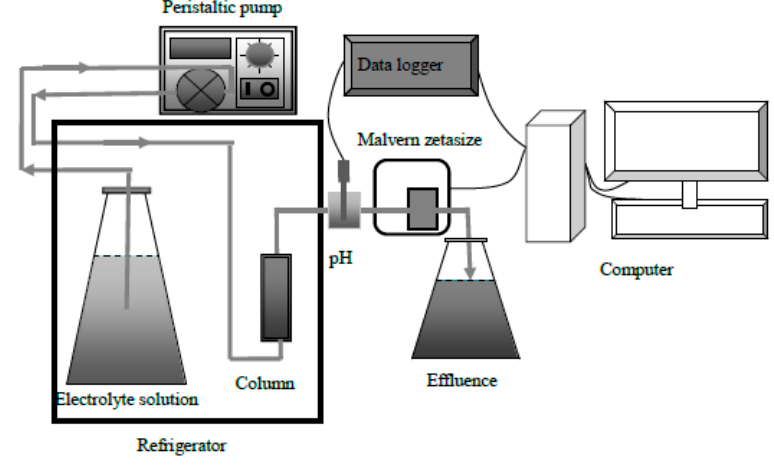
Figure 1. Schematic of the experiment.